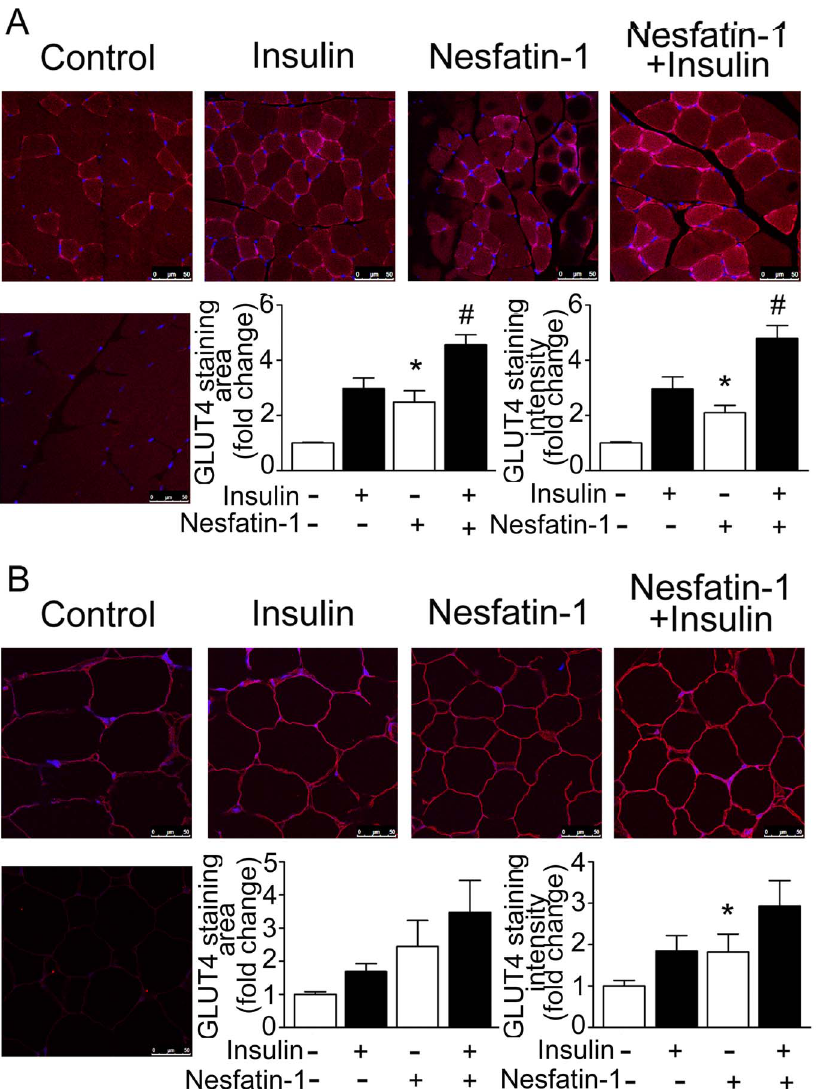
Figure 7. Effects of peripheral nesfatin-1 infusion on GLUT4 in mice fed high fat diet. Immunofluorescent staining was performed using specific antibody against GLUT4 (red) in skeletal muscle and adipose tissue derived from mice consuming high fat diet and either saline (control) or nesfatin-1. Nuclei were stained with Hoechst dye. Controls include substituting primary antibodies with mouse IgG. Shown were representative results from six individual experiments. Images depict immunofluorescent staining for GLUT4 (red) in skeletal muscle (A) and adipose tissue (B). Data are expressed as mean 6 SEM as described in Figure 4. * P , 0.05 vs. control, # P , 0.05 vs. insulin stimulation without nesfatin-1 treatment. Shown were representative results from six individual experiments. mouse IgG. Computerized image analysis (Model Leica Q550CW, Leica Qwin, Germany) was performed to quantify the immuno- staining signals of cytoplasm membrane GLUT4 from mouse gastrocnemius muscle and adipose tissue.